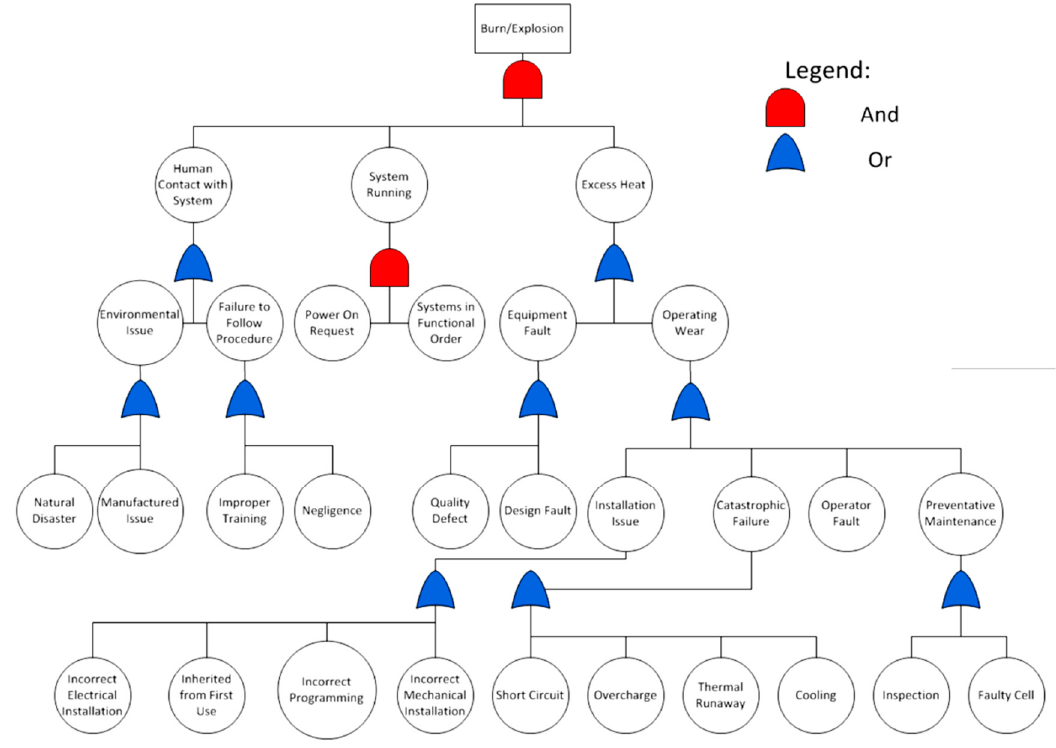
Figure 7. Fault tree analysis (FTA) example for burns/explosions.